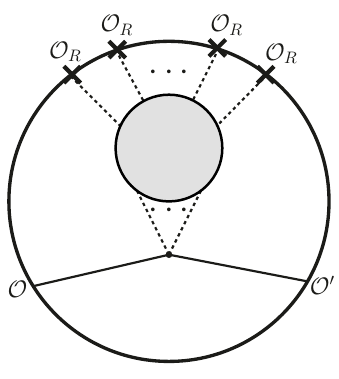
Figure 3 . General structure of \plant" diagrams which lead to e(cid:11)ective Hamiltonian contributions in large N theories. The zero modes (dashed lines) created by the relevant deformation only connect to the physical states (solid lines) via a single contact